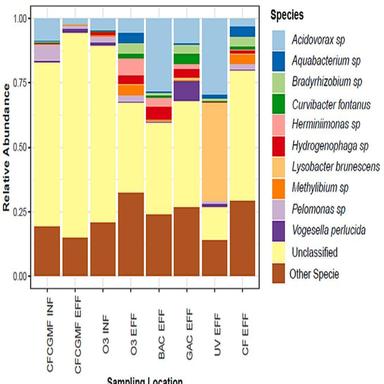
Relative abundance of top 10 species across the treatment train.